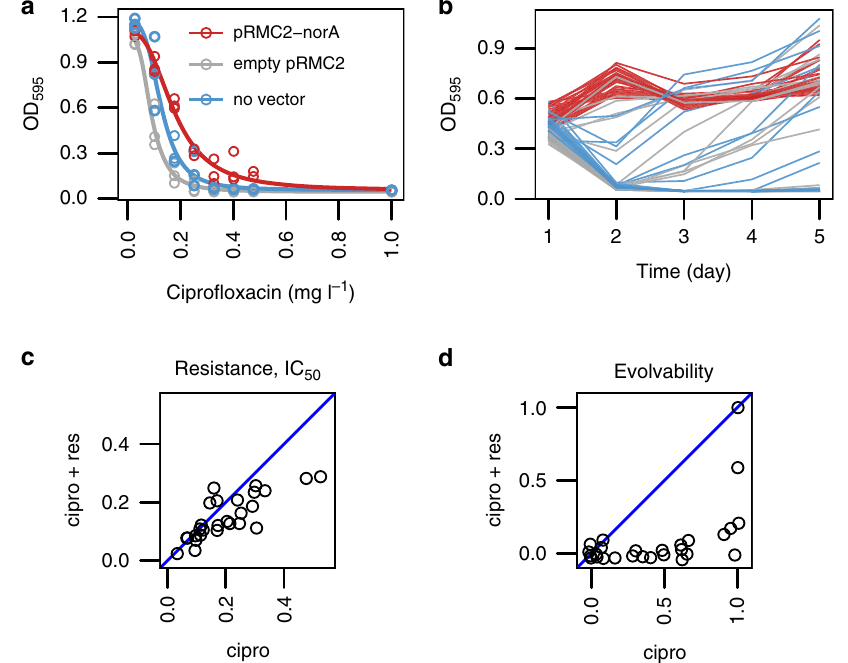
Fig. 4 The role of norA in resistance evolution. a The effect of norA overexpression on cipro fl oxacin resistance. Resistance was measured in the RN4220 cells overexpressing norA from vector pRMC2 under a native promoter (red), compared to an pRMC2 empty vector control (grey) and a vector-free control (blue). N = 3 independent cultures were used per treatment per concentration. Dose-response curves show model fi t from the analysis presented in Supplementary Table 8. b The effect of norA overexpression on the evolution of cipro fl oxacin resistance. Optical density ( λ = 595) was measured for fi ve daily transfers with 1 mg l − 1 of cipro fl oxacin in RN4220 cells overexpressing norA from the pRMC2-norA vector (red), cells with the empty pRMC2 vector (blue) and the cells without the vector (grey). N = 40 independent cultures were used for each type of cells. Statistical analysis in shown in Supplementary Table 10. c The effect of reserpine on intrinsic resistance. Intrinsic resistance to cipro fl oxacin (IC 50 , mg l − 1 ) was determined for a representative set of 27 strains in the presence ( y -axis) or absence of 33 µ M reserpine ( x -axis) ( N = 5 per dose/reserpine combination). Two-sided Wilcoxon signed-rank test: W = 308, d.f. = 26, p = 0.003. d Evolvability was determined for the same set of 27 strains with 33 µ M reserpine ( y -axis) or without reserpine ( x -axis). Evolvability was measured as the probability of population survival after 5 serial transfers at 1 mg l − 1 of cipro fl oxacin ( N = 16 replicate populations for each strain/reserpine combination). Two-sided Wilcoxon signed-rank test: W = 226, N = 27, p -value =